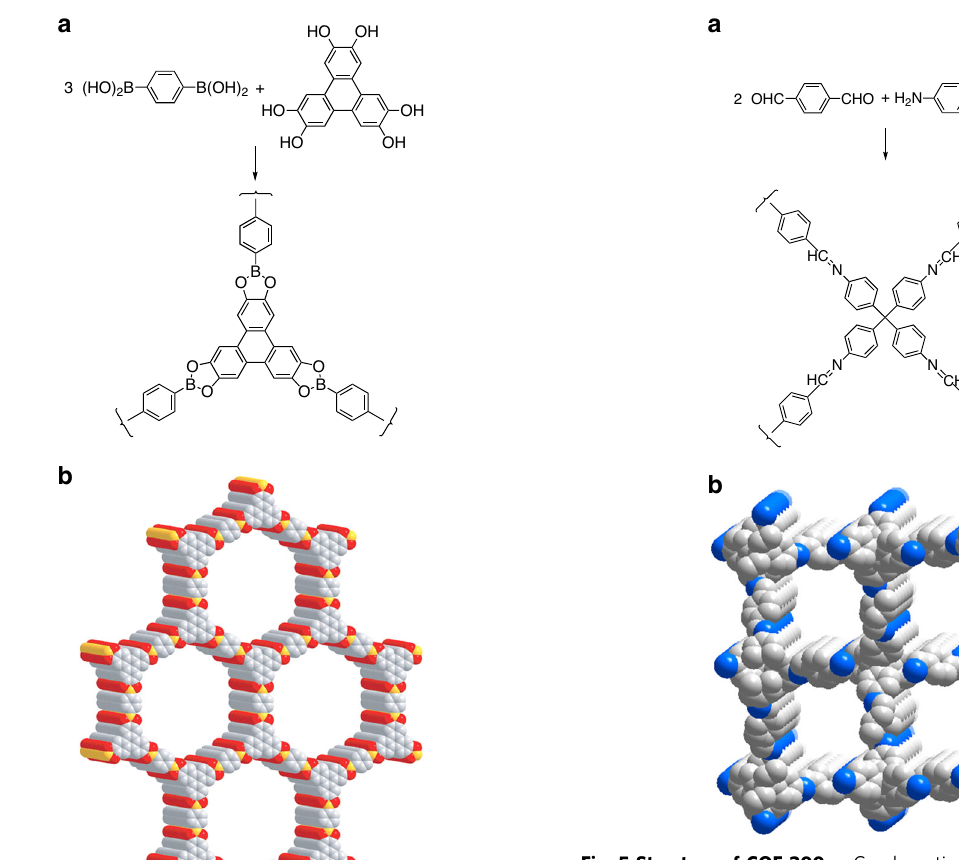
Fig. 5 Structure of COF-300. a Condensation of 1,4- benzenedicarboxaldehyde with tetrakis(4-aminophenyl)methane to form COF-300. b Model of the postulated fi vefold interpenetrated diamondoid structure of COF-300 based on PXRD, showing channels along the c -axis. Atoms of carbon are shown in gray, atoms of nitrogen appear in blue, and atoms of hydrogen are omitted for clarity. Adapted with permission from ACS, ref. 28 .